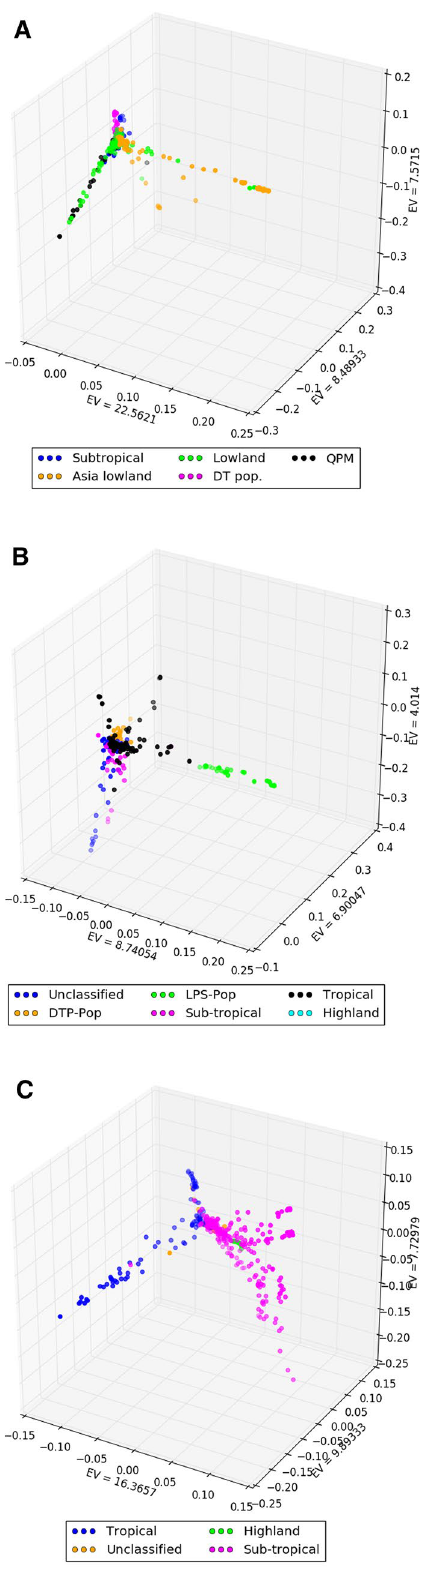
Figure 2. Population structure based on the first three Eigen values of principal components (PC) analysis of ( A ) CAAM panel using 64,344 SNPs ( B ) DTMA panel using 69,254 SNPs and ( C ) IMAS panel using 69,286 SNPs. Different coloured clusters represented the adaptation pattern of the three